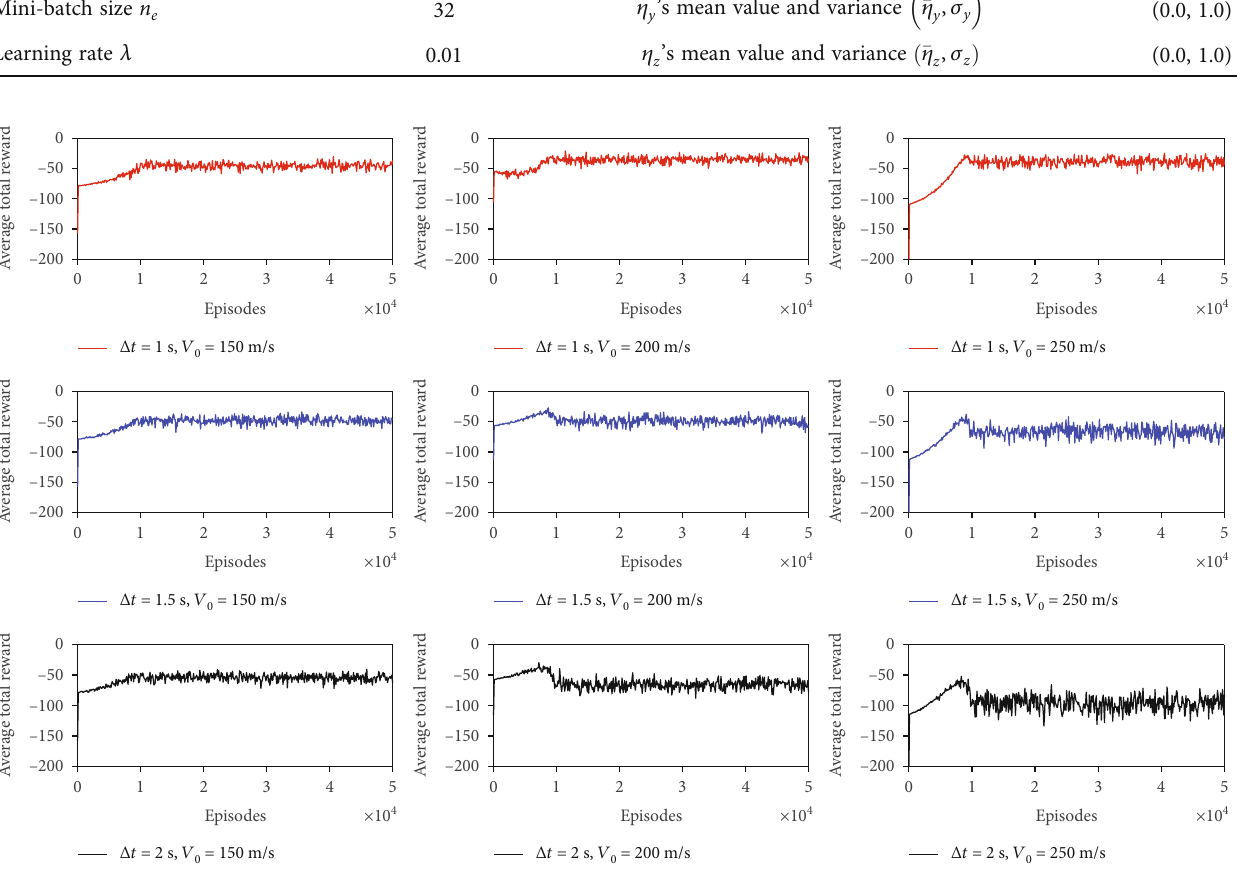
Figure 6: The change of the average total rewards per episode in tests